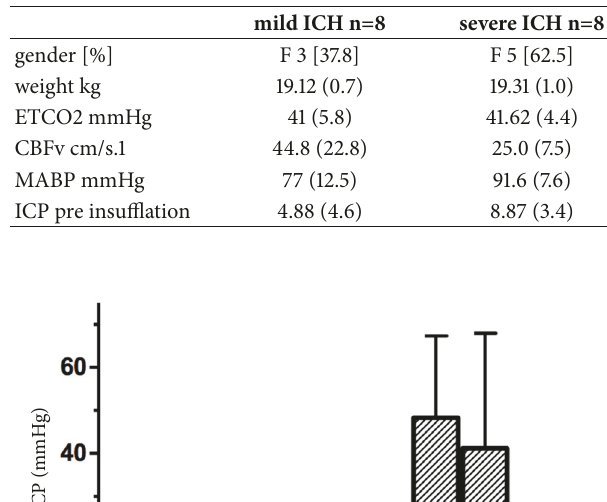
Table 1: Demographic and clinical characteristics of the piglets (SD); ICH (intracranial hypertension), ETCO 2 (end tidal CO 2 ), CBFv (cerebral blood flow velocity), MABP (mean arterial blood pressure), and ICP (intracranial pressure).